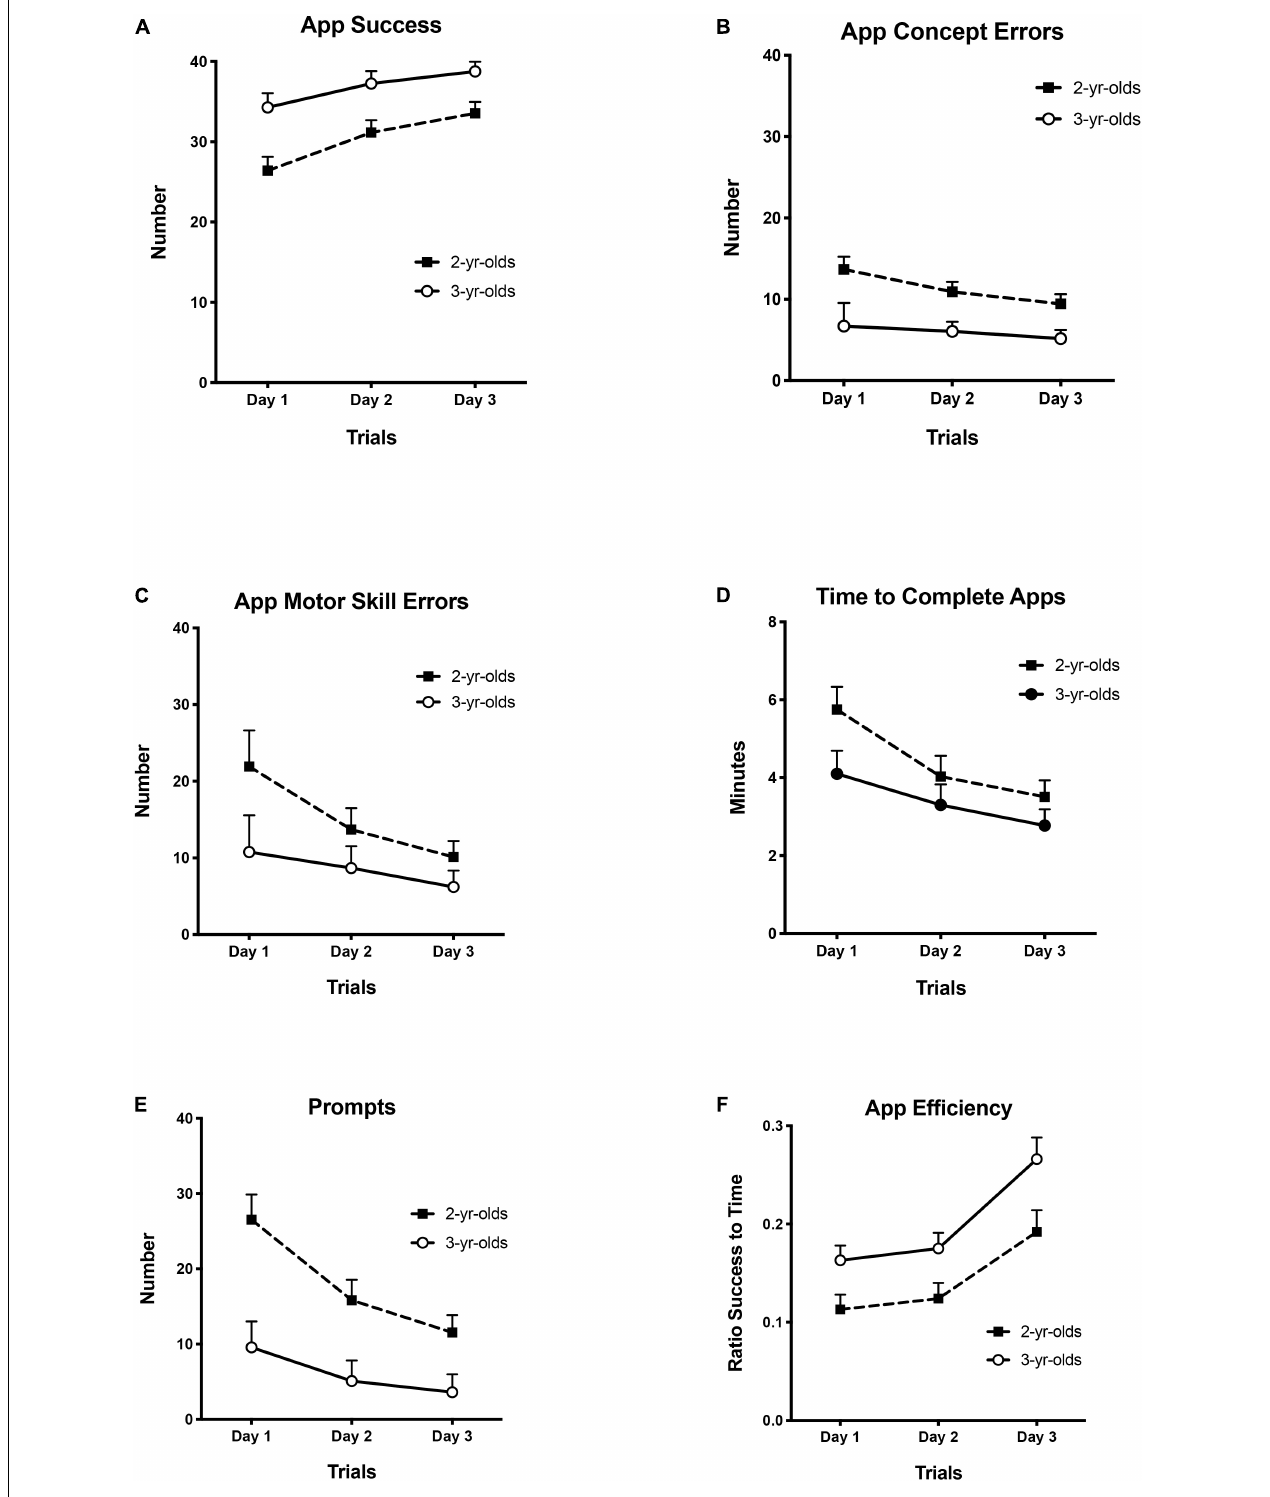
FIGURE 4 | Adjusted means and standard errors for shape matching app performance by age and trials: Number of (A) successes (max = 47), (B) concept errors, (C) motor skill errors, (D) completion time in minutes, (E) number of prompts, and (F) efficiency ratio.